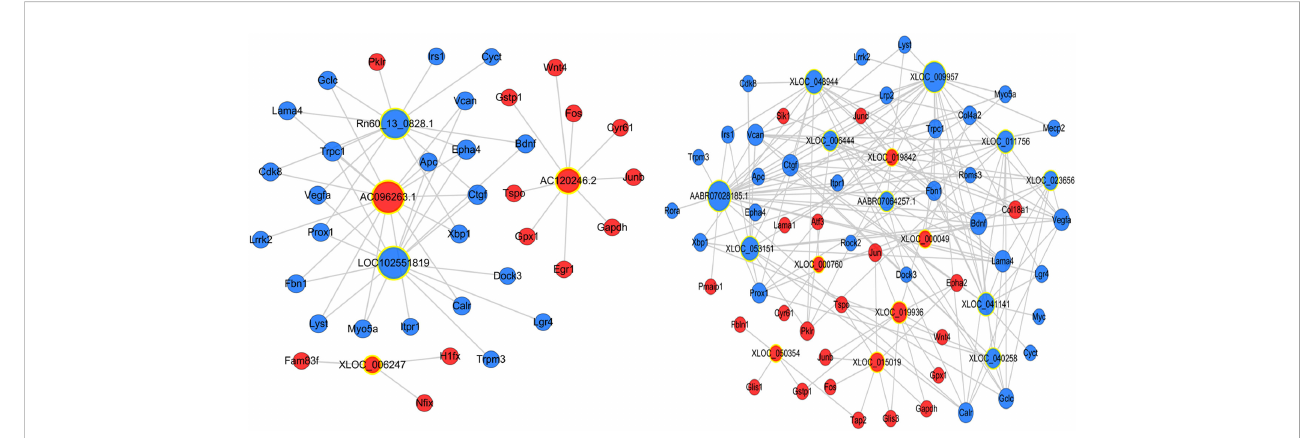
FIGURE 4 Construction of the lncRNA-mRNA co-expression network. A node with a yellow ring indicates lncRNA and a node without a yellow ring indicates mRNA. Upregulated lncRNAs and mRNAs are shown in red and downregulated lncRNAs and mRNAs are shown in blue.